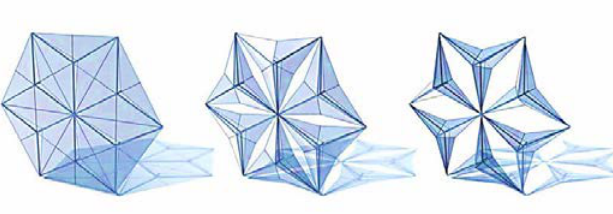
Fig 5(c) The geometric pattern coated with